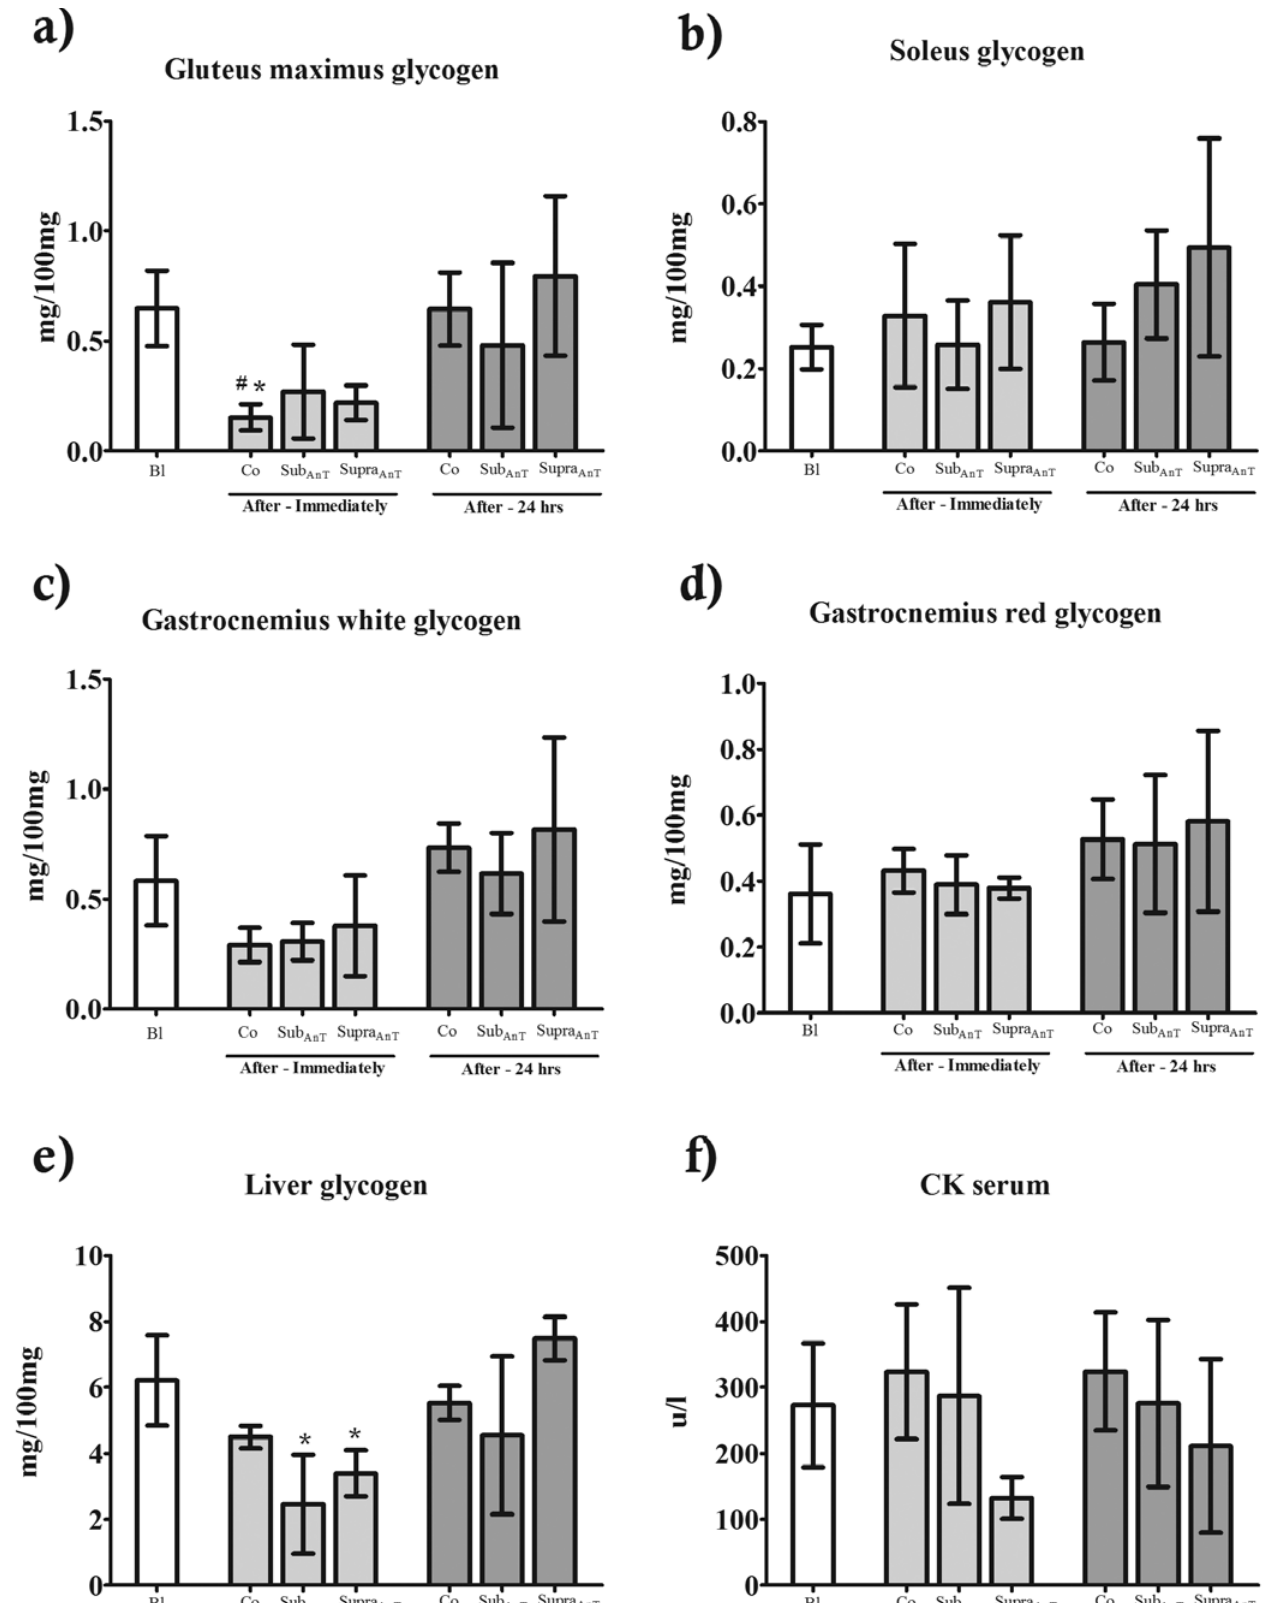
Figure 3. Muscle/hepatic glycogen content and serum creatine kinase (CK) comparison between baseline (Bl), control (Co), sub anaerobic threshold (SubAnT) and supra anaerobic threshold (SupraAnT) groups. #Indicate difference from Co group; *Indicate difference from SupraAnT